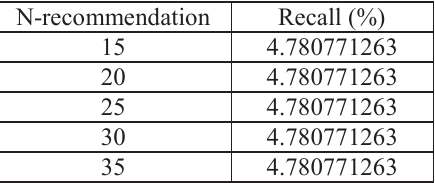
Table 3. N-recommendation vs